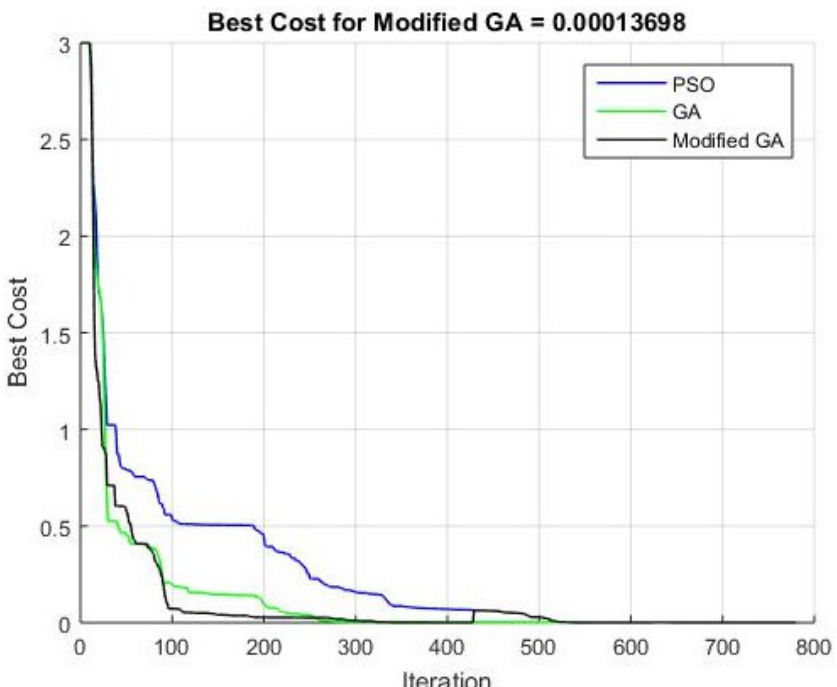
Figure 9. Best Cost vs. Iteration using various optimization